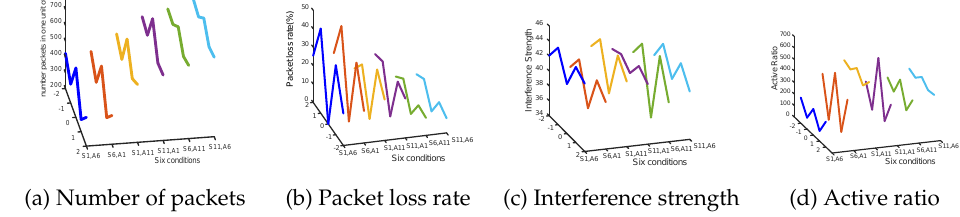
Figure 7. Four parameters to characterize the channel interference between the safe wireless transmitter and the public AP that the attacker leverages under six conditions.